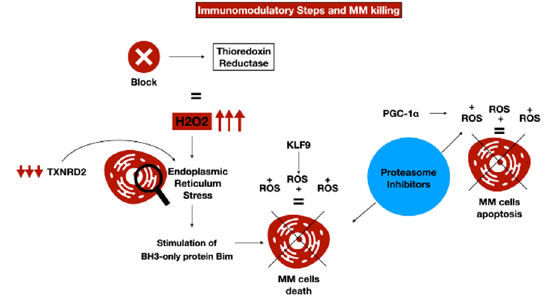
Figure 2. Immunomodulatory steps and MM cell death with the proteasome inhibitors’ potential